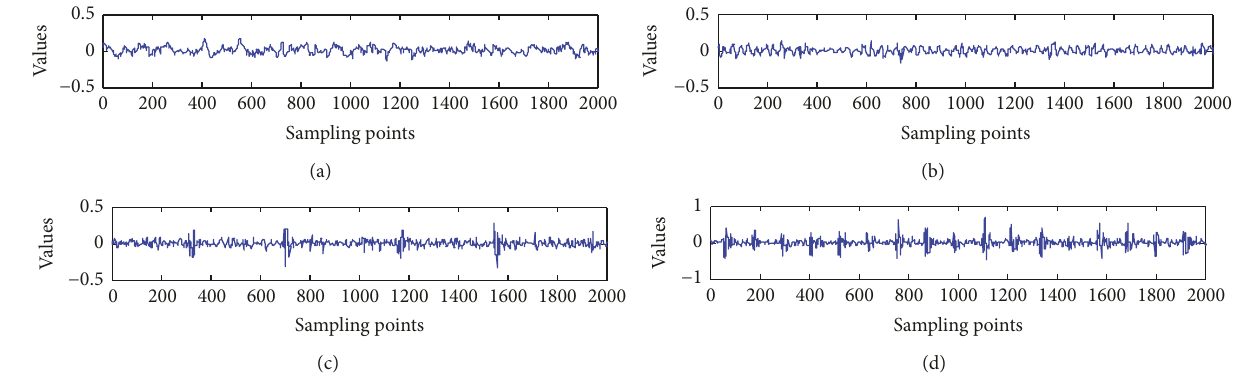
Figure 8: Waveforms after filtering (a) normal status, (b) rolling bearing fault, (c) inner ring fault, and (d) outer ring fault.